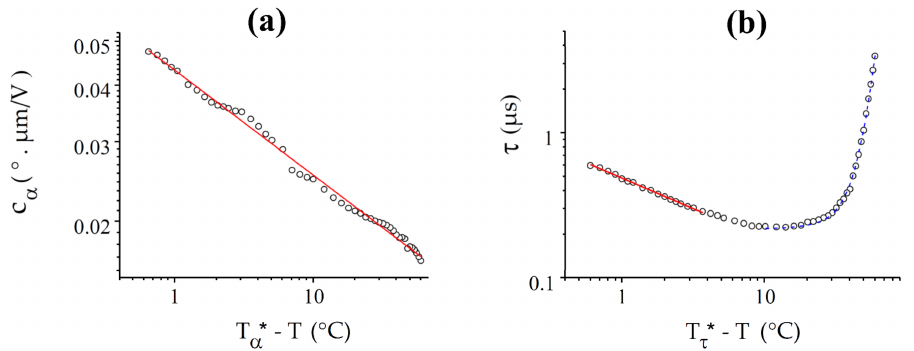
Figure 8. Best fits (red solid lines) of c α ( T ) and τ ( T ) with power laws for CB7CB: ( a ) For c α ( T ) , the fit c α ( T ) ∝ ( T α * − T ) − β α is good over the entire (60 ◦ C) range under study, with T α * = 100.05 ◦ C and β α = 0.23; ( b ) For the response time, the law τ ( T ) ∝ ( T τ * − T ) − β τ , with T τ * = 100.20 ◦ C and β τ = 0.42 fits the curve well only in a range of about 6 ◦ C. At low temperature, the curve is well-fitted by an exponential growth law (blue dashed curve).